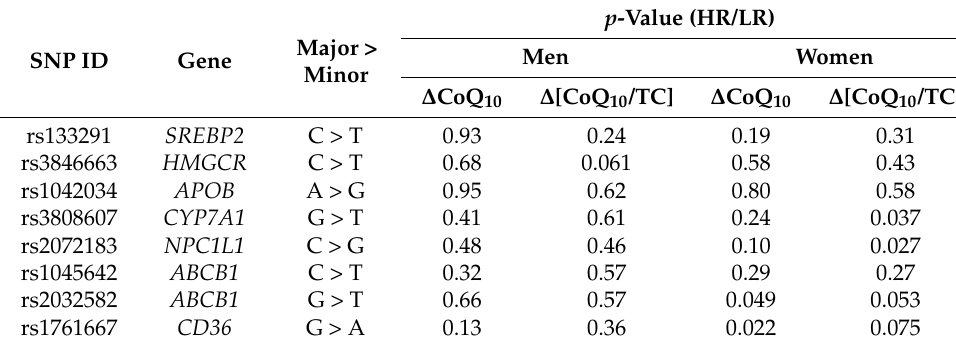
Table 3. Association of single nucleotide polymorphism (SNP) genotypes with high-responder (HR)/ low-responder (LR)